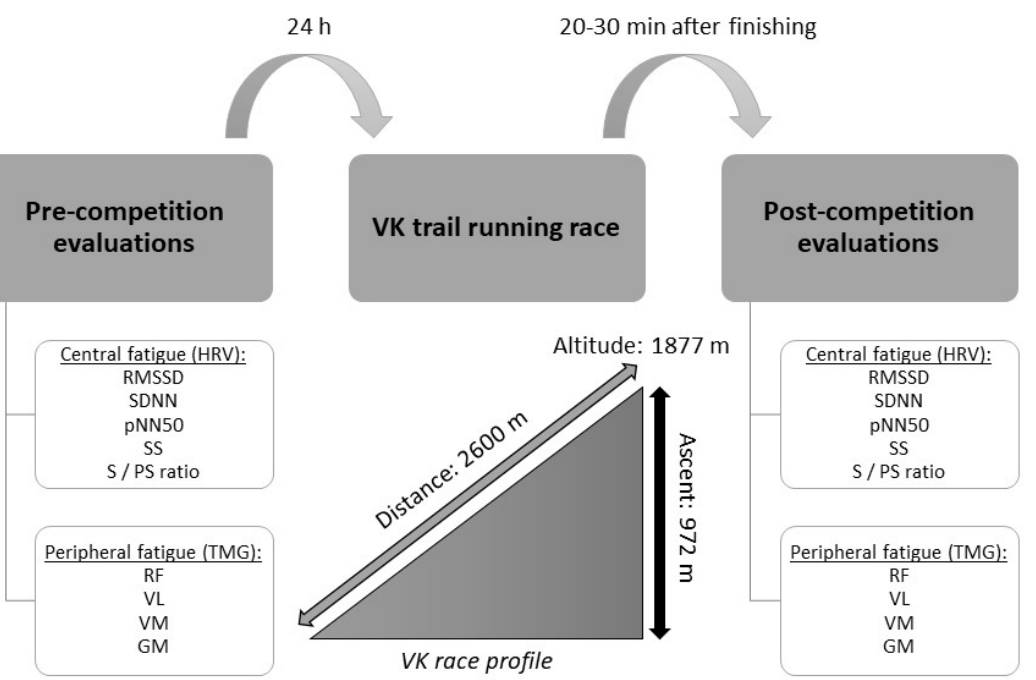
Figure 1. Experimental design scheme. VK: vertical kilometer; HRV: heart rate variability; RMSSD: square root of the mean of the squared differences between successive normal–to–normal intervals; SDNN: standard deviation of normal–to–normal intervals; pNN50: percentage of successive RR intervals that differ by more than 50 ms; SS: stress score; S/PS ratio: ratio between the sympathetic nervous system and the parasympathetic nervous system activity; TMG: tensiomyography; RF: rectus femoris; VL: vastus lateralis; VM: vastus medialis; GM: gastrocnemius medialis.